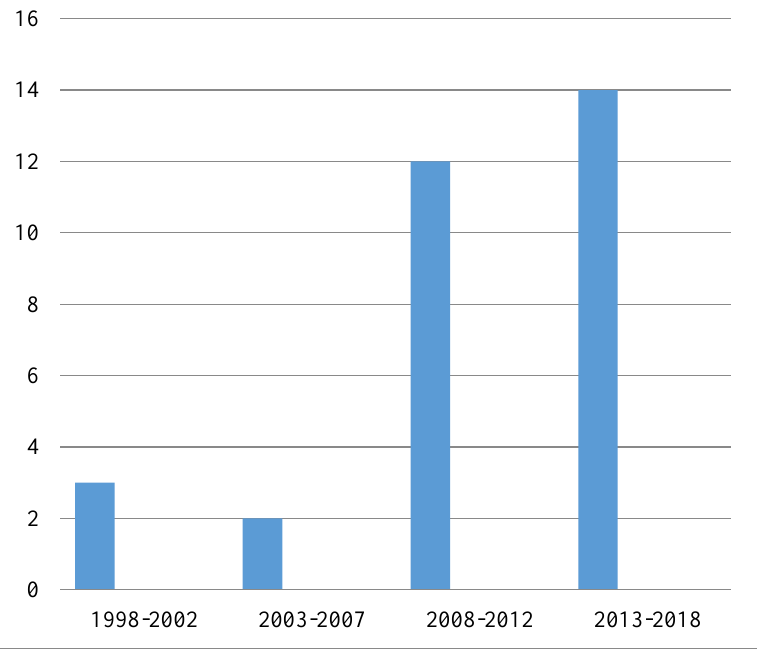
Figure 6. Period of 31 papers that showed the agreement about definition of MCPs. “Source: